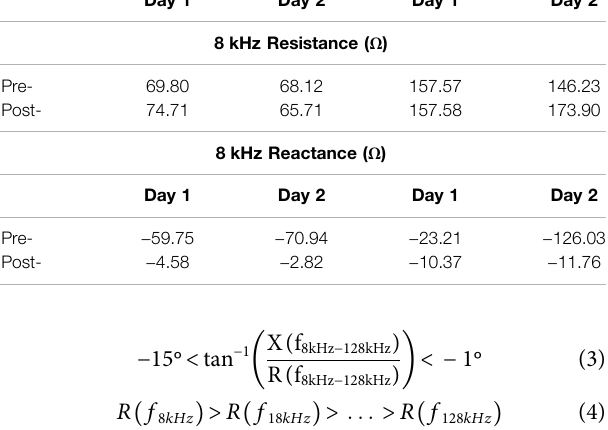
TABLE 2 | Day 1 and 2 mean 8 kHz resistance and reactance of Participant 3 using pre- and post-processed data. Dataset Transverse